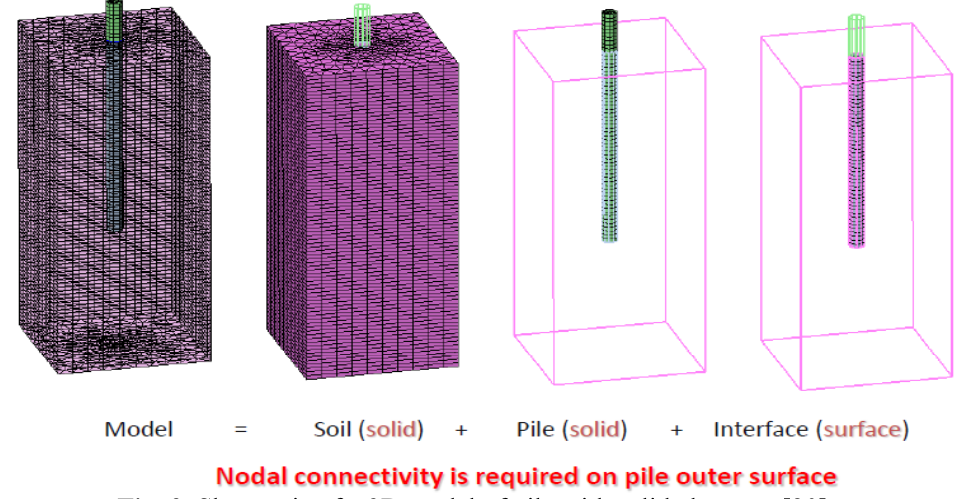
Fig. 3. Shcematic of a 3D model of pile with solid elements [20].